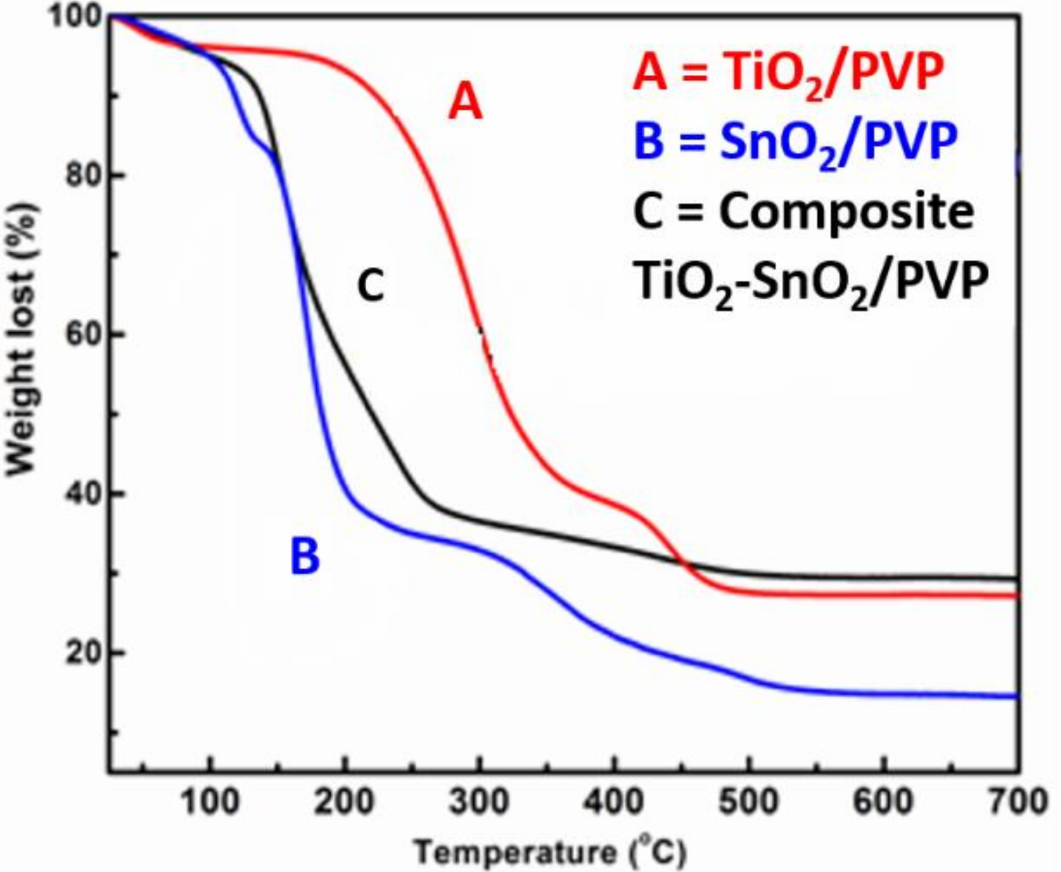
Figure 2. TGA thermograms of the as-spun nanofibers of ( A ) TiO 2 /PVP; ( B ) SnO 2 /PVP; and ( C ) composite TiO 2 -SnO 2